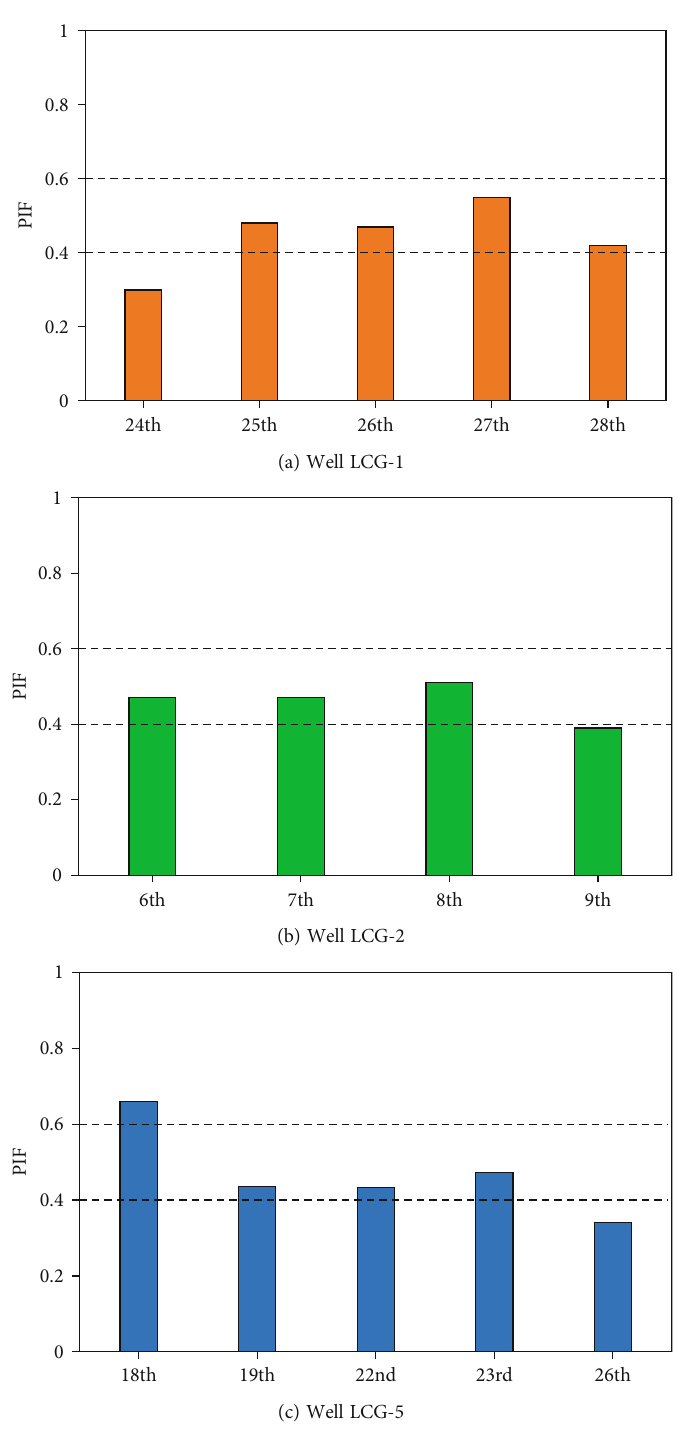
Figure 8: The PIF at each stage of LCG-1, LCG-2, and